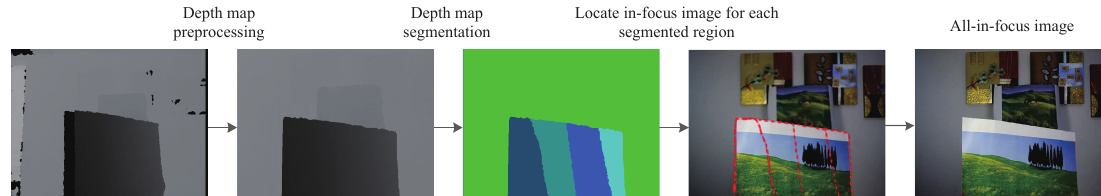
Figure 3. Main steps and intermediate results when applying the proposed multi-focus image fusion method to construct an all-in-focus image of a real